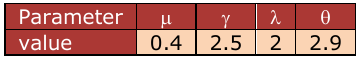
Table 2. Parameter Value of Familiar Passengers